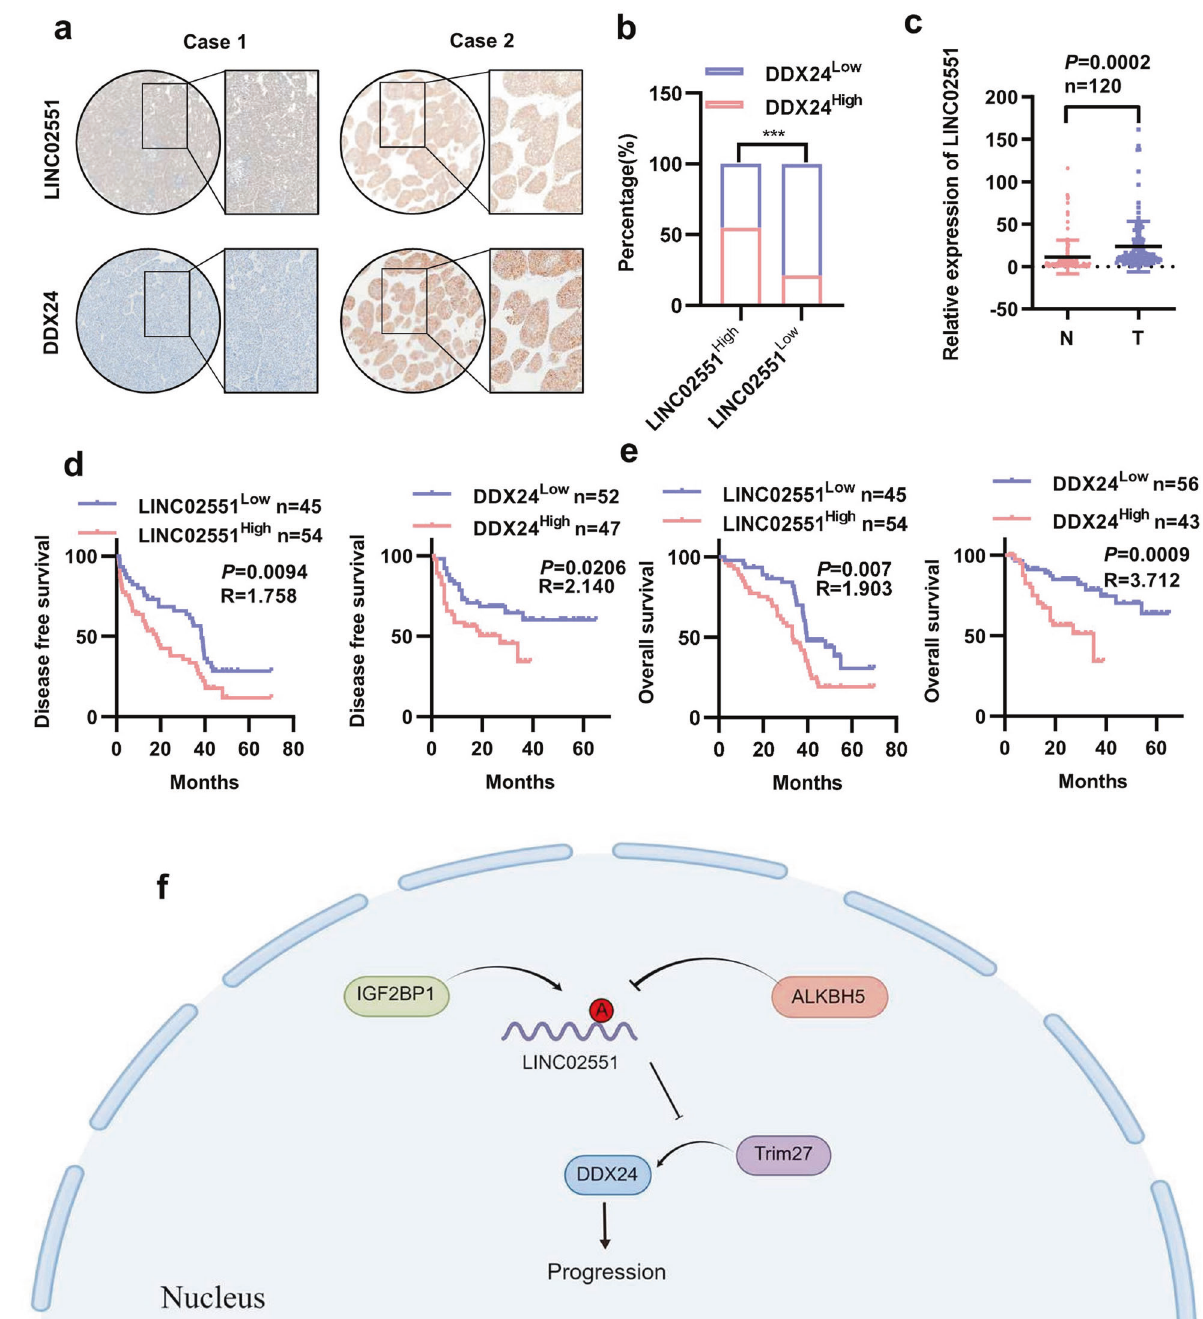
Fig. 7 LINC02551 is positively correlated with DDX24 expression in HCC patient samples. a Representative IHC staining results in paraf fi n- embedded HCC samples from Tongji Hospital. b Statistical results indicated that LINC02551 expression was positively correlated with DDX24. P values were calculated by Pearson ’ s chi-square test. c Statistical analysis of the qRT-PCR results showing LINC02551 expression in cohort 2 ( n = 120). d The disease free survival prognosis of patients determined on the basis of LINC02551 and DDX24 expression in cohort 1 ( n = 99). e The overall survival prognosis of patients determined on the basis of LINC02551 and DDX24 expression in cohort 1 ( n = 99). P values represent log-rank testing of difference in cumulative survival. f Schematic illustration showing the roles played by LINC02551 in HCC